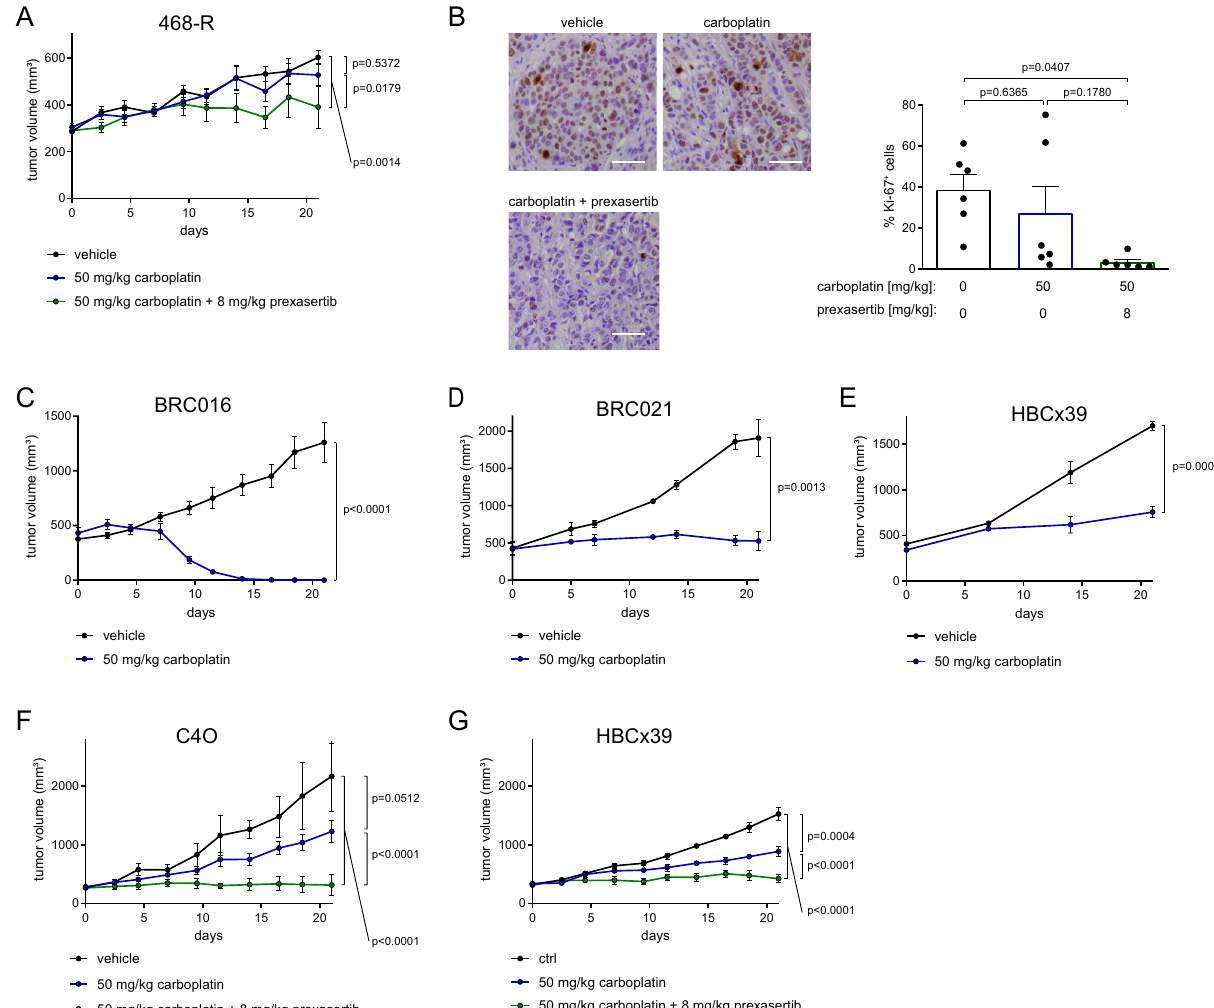
Figure 6. A low dose of prexasertib in combination with carboplatin overcomes platinum resistance in TNBC xenograft models. ( A,B ) tumor growth ( A ) and Ki67 positivity ( B ) of 468-R TNBC cell line xenografts treated with vehicle (N = 6), 50 mg/kg carboplatin (N = 7), or 50 mg/kg carboplatin and 8 mg/kg Prexasertib (N = 6) for three weeks. Scale bar, 50 µm. Data are shown as Mean ± SEM. P values were determined by two-way ANOVA with Geisser–Greenhouse and Tukey’s corrections, N = 6 for each condition. ( C–E ) The indicated patient- derived TNBC xenografts were treated with vehicle or 50 mg/kg carboplatin for 3 weeks. Tumor volumes of BRC016 (N = 9) ( C ), BRC021 (vehicle, n = 3; carboplatin n = 2) ( D ) and HBCx39 (N = 3) ( E ) PDX models are shown as Mean ± SEM. P values were determined by two-way ANOVA with Geisser–Greenhouse correction. ( F,G ) The growth of C4O (N = 3 per condition) ( F ) and HBCx39 (N = 6 vehicle-treated; N = 6 carboplatin- treated; N = 7 carboplatin + prexasertib-treated) ( G ) PDX xenografts. PDX tumors were treated with vehicle, 50 mg/kg carboplatin, or 50 mg/kg carboplatin and 8 mg/kg Prexasertib, for 3 weeks. Data are shown as Mean ± SEM. P values were determined by two-way ANOVA with Geisser–Greenhouse and Tukey’s